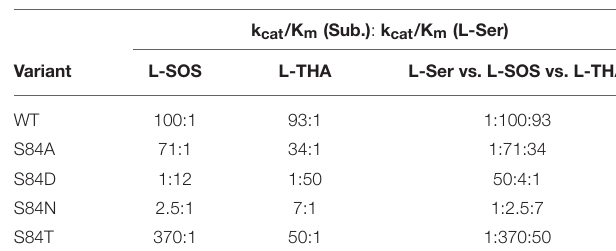
TABLE 1 | Kinetics of hSR mutants highlighting the S84D mutants switch in preference to elimination of serine over charged substrates and the interesting preference of S84T for L-SOS over L-THA [table adapted with permission of the American Society for Biochemistry and Molecular Biology (ASBMB) (Nelson et al.,